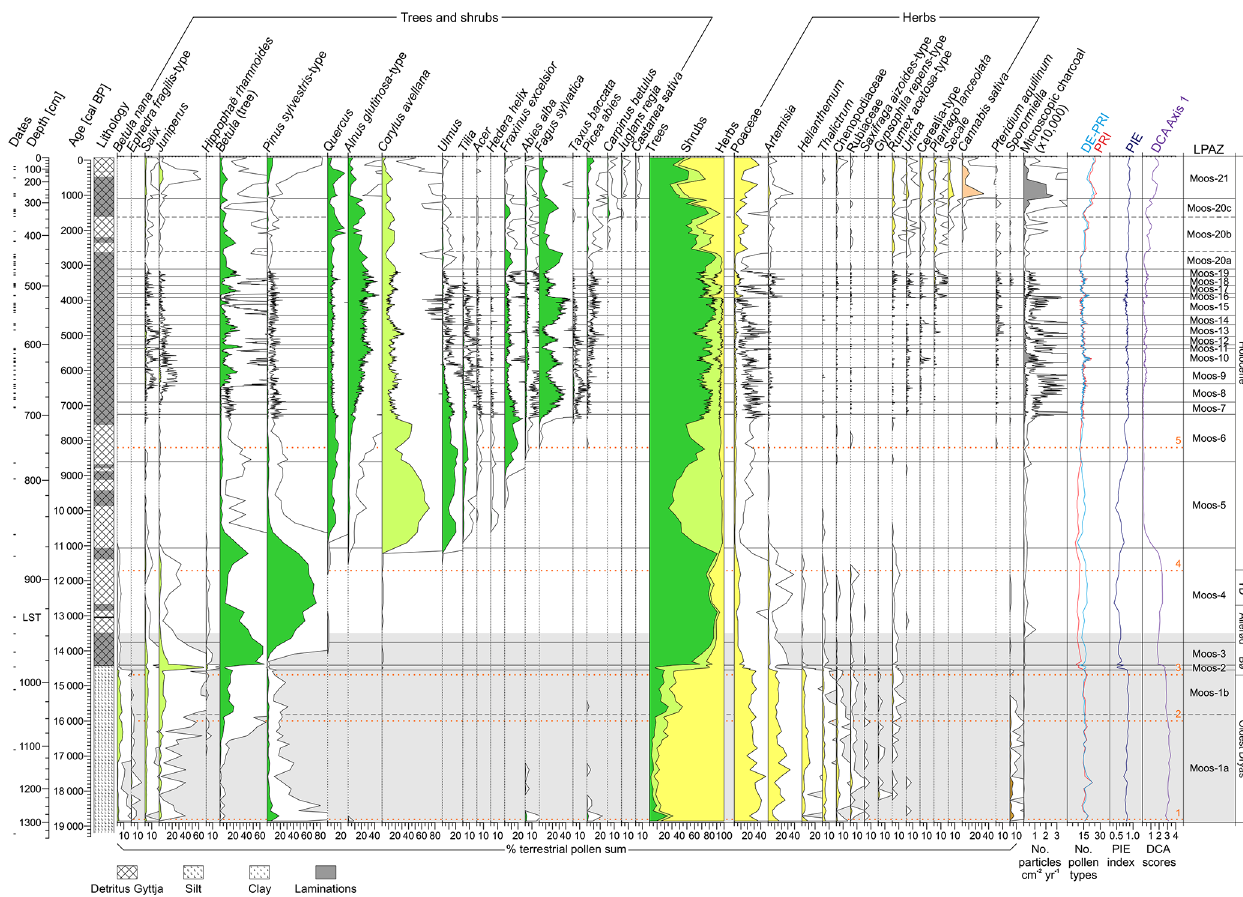
Figure 3. Moossee sediment sequence. Presented are the dates (small black lines), the lithology, percentages of selected pollen types, Pteridium aquilinum (fern spore) and Sporormiella (coprophilous fungal spore), microscopic charcoal influx values, the palynological richness (PRI; red line), the evenness-detrended palynological richness (DE-PRI; light blue line), the palynological evenness (PIE; dark blue line) as well as the detrended correspondence analysis (DCA; purple line). Empty curves show 10 × exaggerations. LST: Laacher See Tephra; Bø: Bølling; YD: Younger Dryas. The horizontal light grey bar indicates the time window of Fig. 4. The orange horizontal dotted lines (1–5) mark important climatic breaks on the basis of temperature changes (Finsinger et al., 2019) and/or changing moisture availability (e.g., Joannin et al., 2013). 1: onset of the Oldest Dryas (19000calBP; Wirsig et al., 2016); 2: post-HE-1 warming (16000calBP; Samartin et al., 2012); 3: onset of the Bølling (14700calBP; van Raden et al., 2013); 4: onset of the Holocene (11700calBP; Heiri et al., 2015); 5: 8.2ka event (8200calBP; Tinner and Lotter,